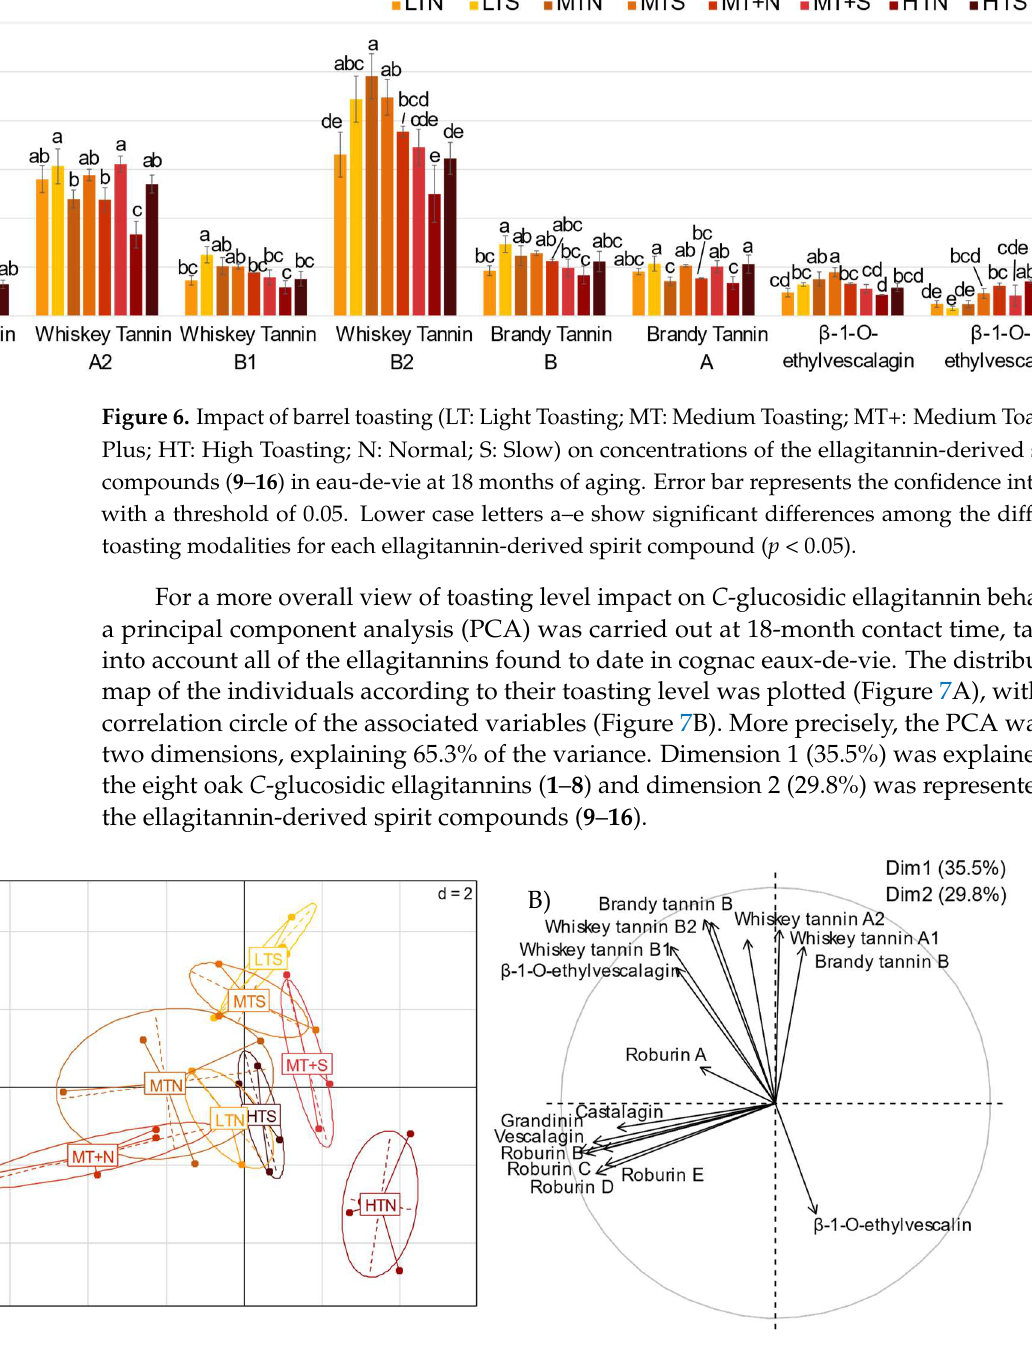
Figure 7. Principal component analysis (PCA) on two dimensions after 18 months of aging representing ( A ) the distribution map of the individuals according to toasting level (LT: Light Toasting; MT: Medium Toasting; MT+: Medium Toasting Plus; HT: High Toasting; N: Normal; S: Slow) and ( B ) the correlation circle of the associated variables.